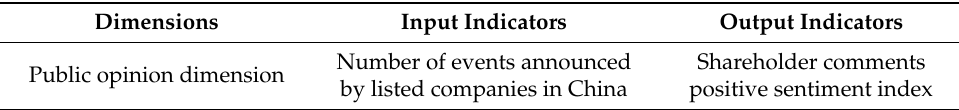
Table 5. Public opinion dimension evaluation index